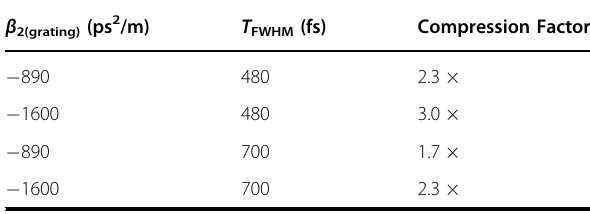
Table 1 Experimentally measured spectral compression factor as a function of β 2(grating) and T FWHM β 2 /m) 2(grating) (ps